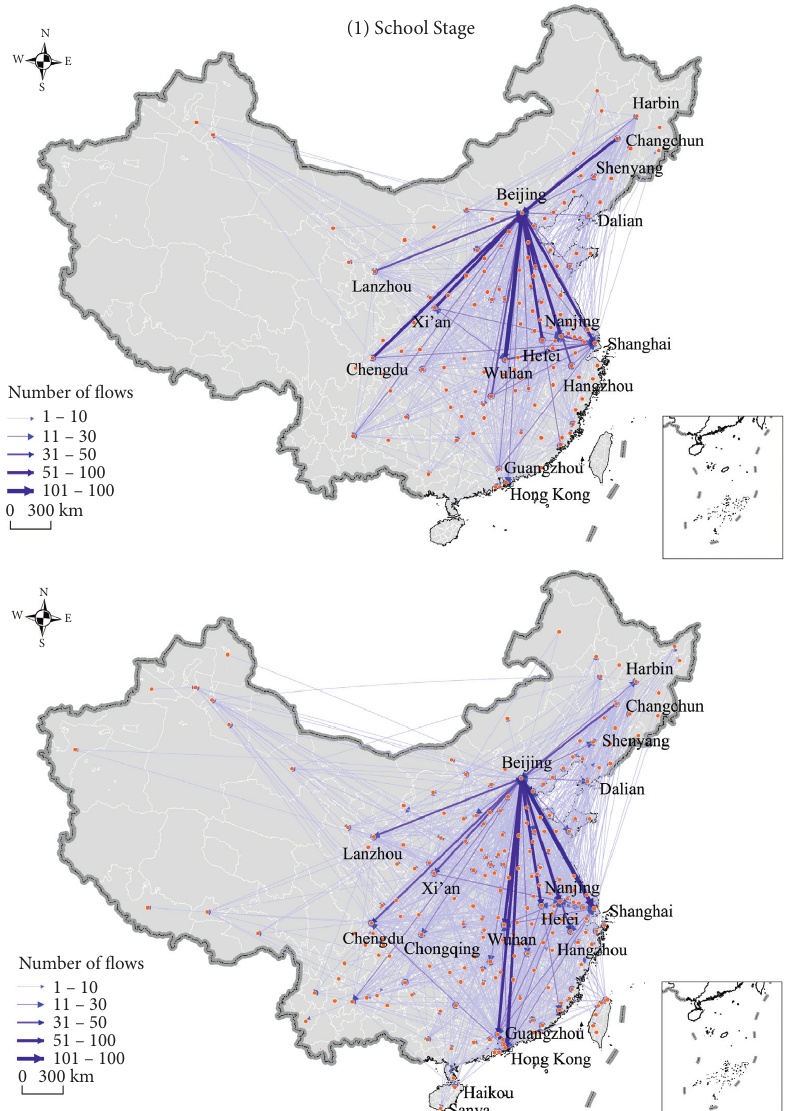
Figure 3: Changes in the spatial structure of the talent mobility network. (a) School stage. (b) Work